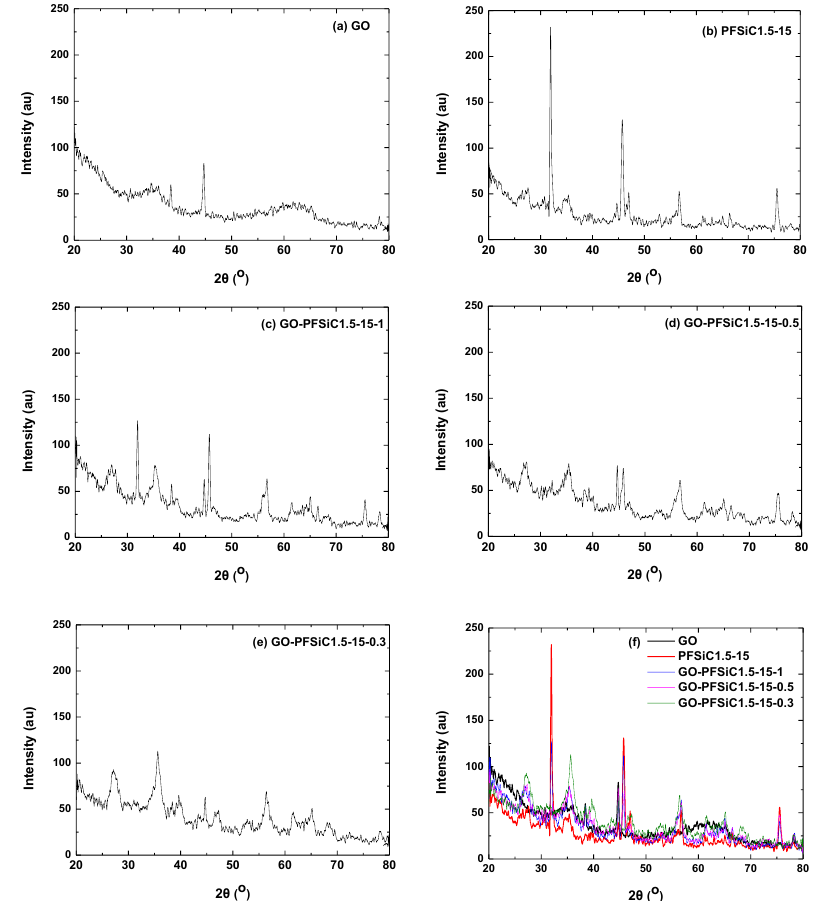
Figure 3. XRD diagrams of the examined materials; ( a ) GO, ( b ) PFSiC 1.5-15 , ( c ) GO-PFSiC 1.5-15-1 , ( d ) GO- PFSiC 1.5-15-0.5 , ( e ) GO-PFSiC 1.5-15-0.3 , and ( f ) comparison between them.